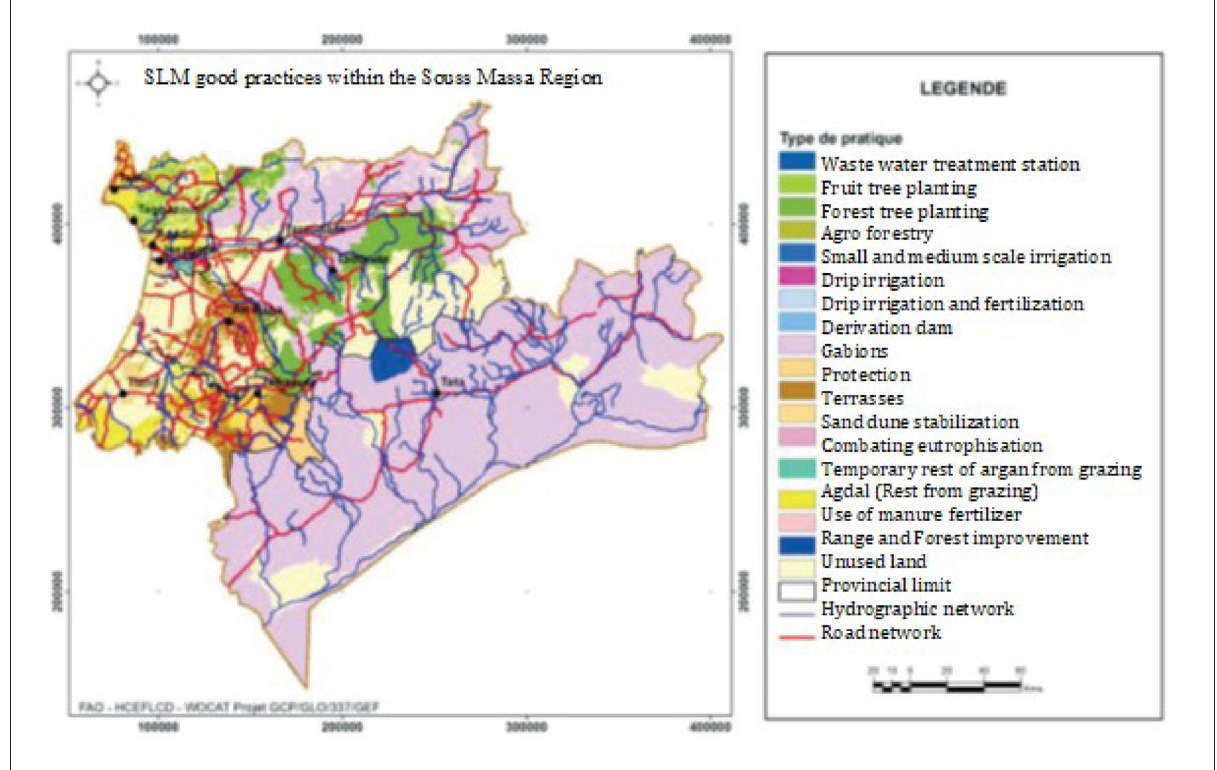
FIGURE9 Map of SLM technologies in the Souss-Massa